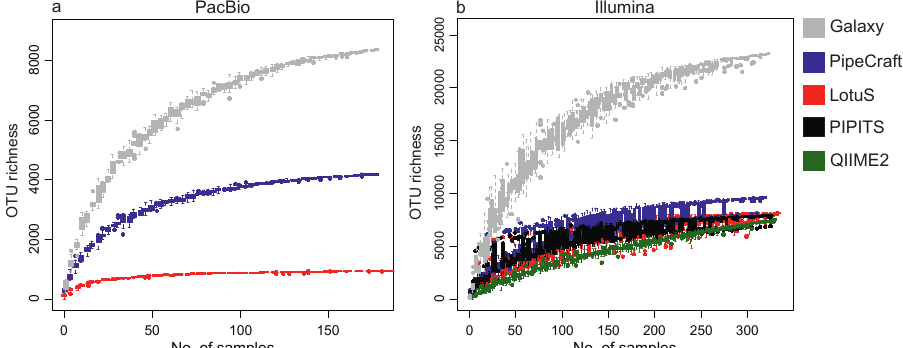
Figure 2. OTU accumulation curves of the evaluated pipelines for a) PacBio and b) Illumina datasets.